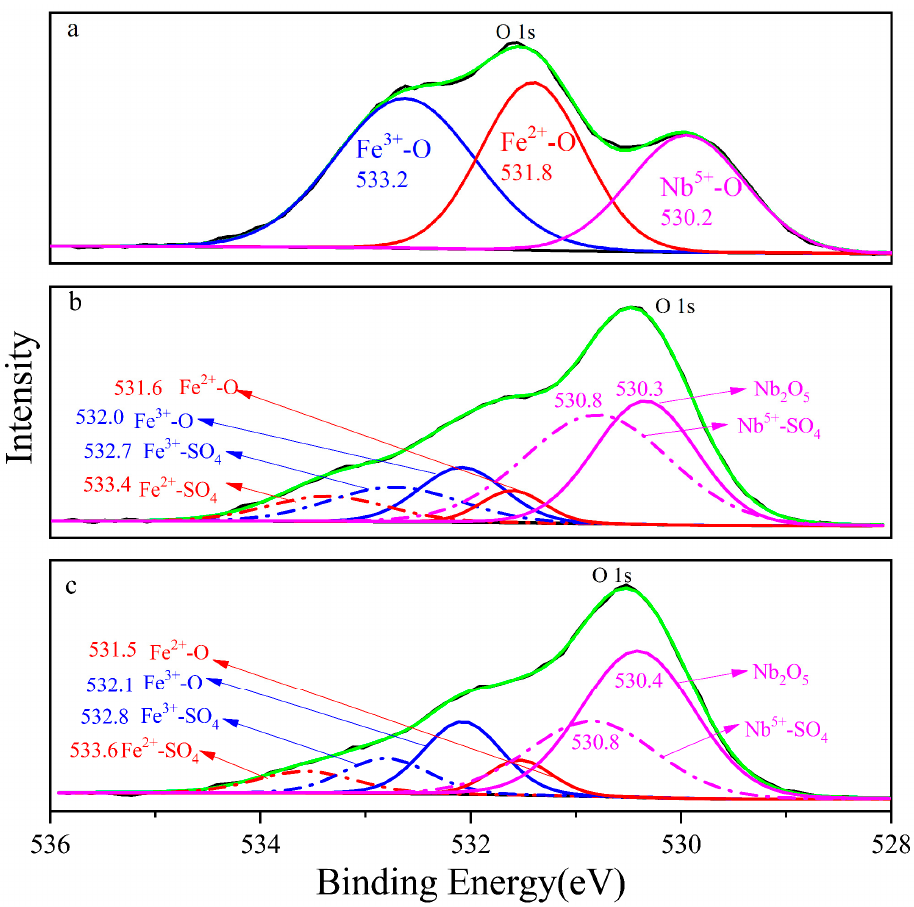
Figure 5. The photoelectron spectrum of O 1s, ( a ) columbite-(Fe); ( b ) 8 M H 2 SO 4 acid leaching residue; ( c ) 12 M H 2 SO 4 acid leaching residue.